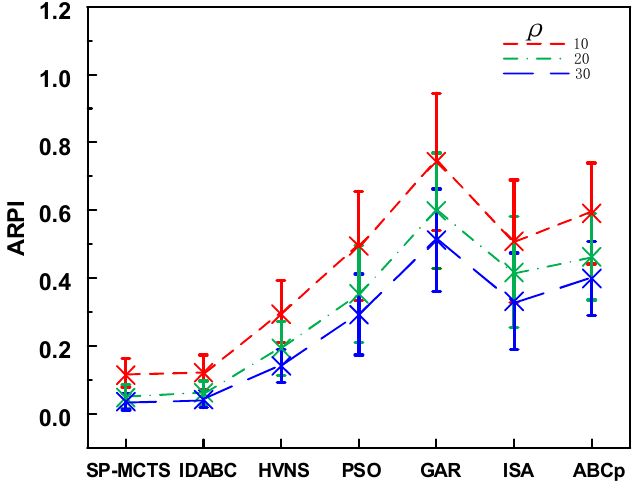
Figure 3. The means plot and 95% Tukey HSD confidence intervals for the interaction between the algorithms and the allowed CPU time. algorithms and the allowed CPU